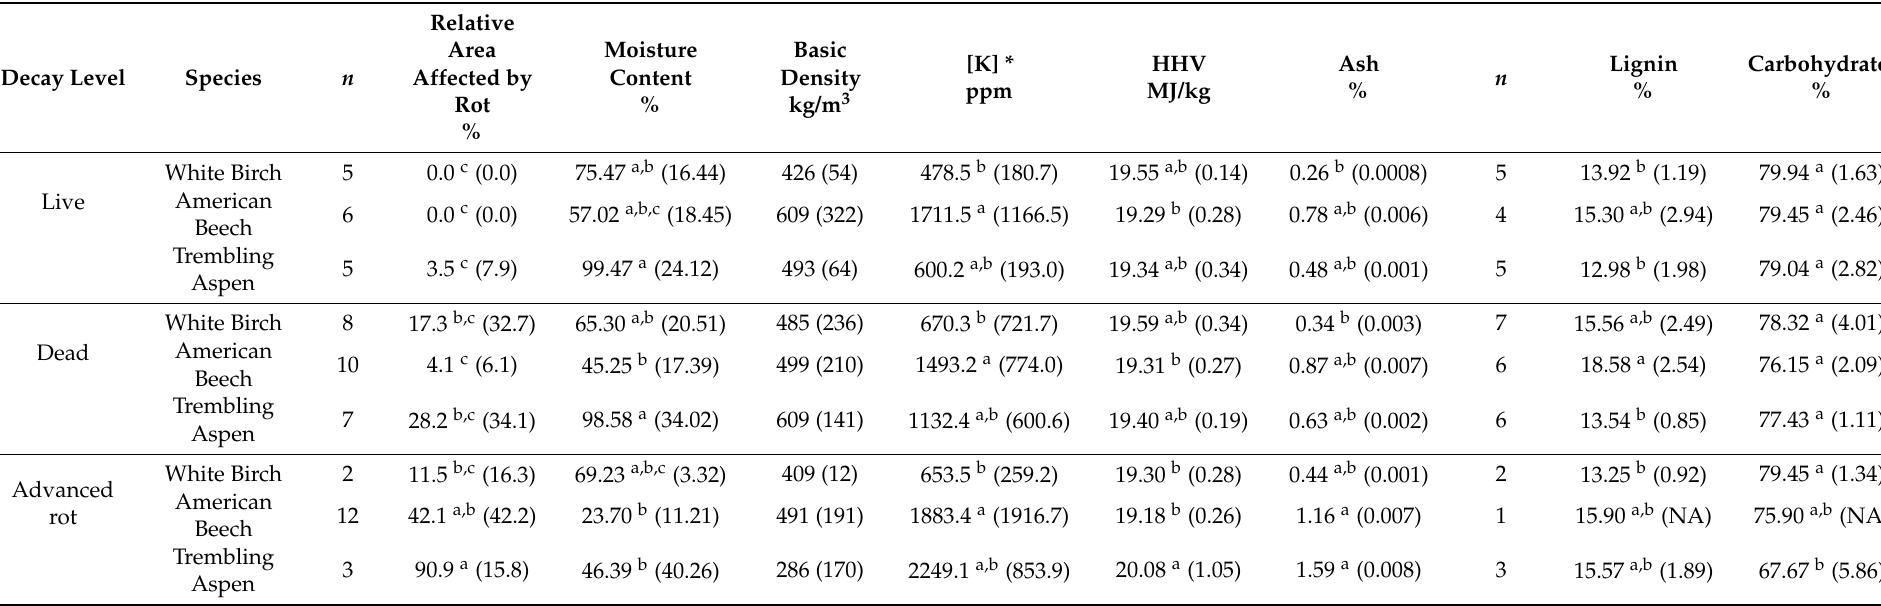
Table 3. Physical and chemical properties of hardwoods at different decay levels. n = number of samples. Values in parenthesis show standard deviation.